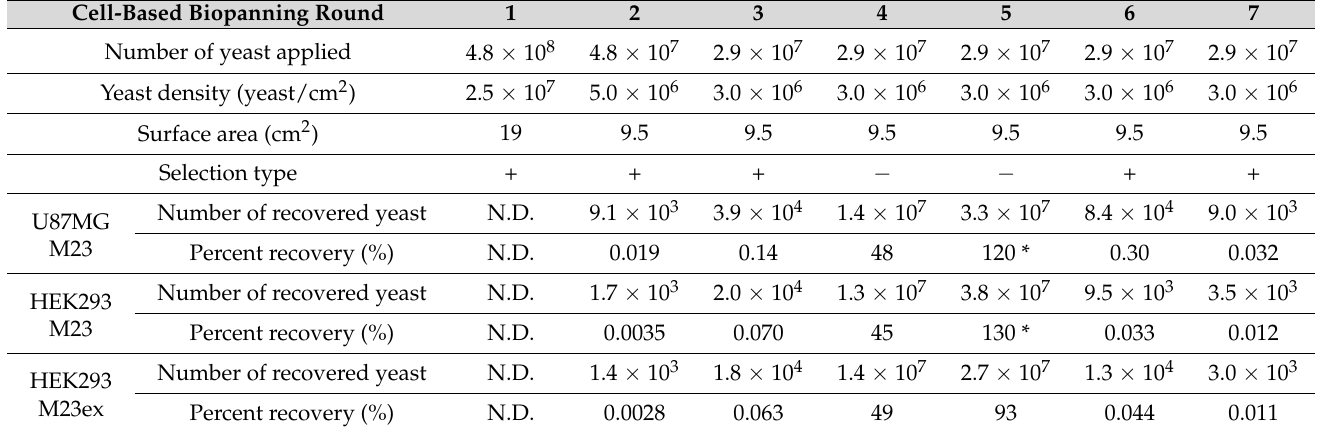
Table 1. Summary of cell-based biopanning parameters and